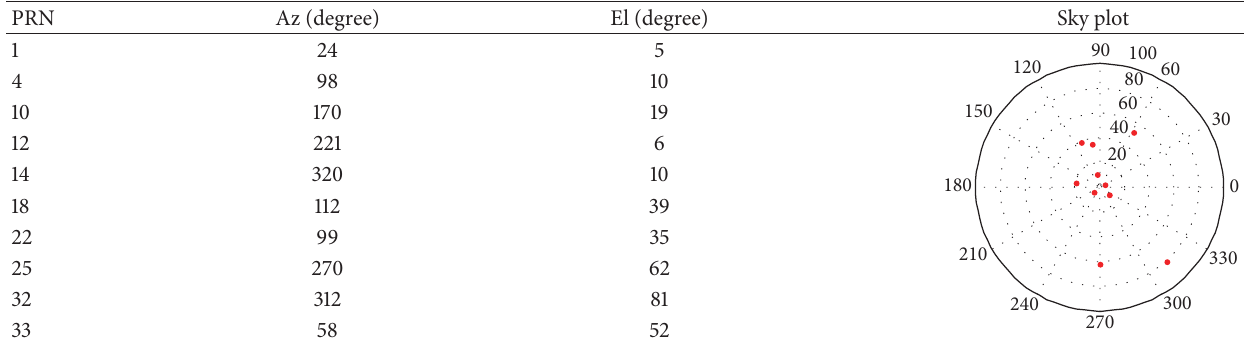
Table 2: Azimuth and elevation angles of visible satellites.